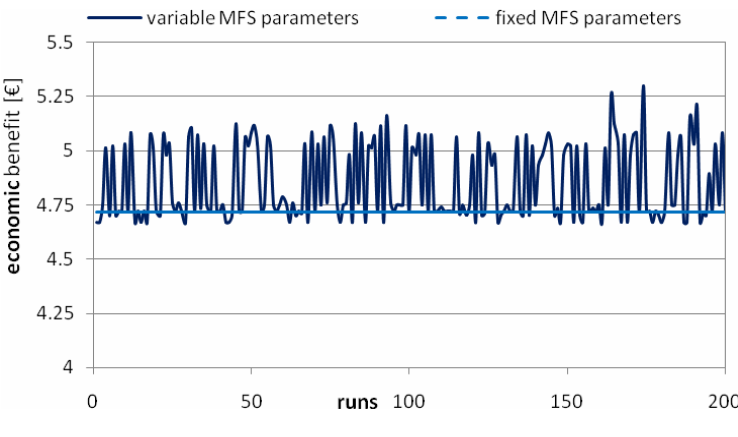
Figure 22. Comparison of the economic benefit after two weeks obtained in 200 runs for fixed and self-adapting sets of MFs parameters—unstable